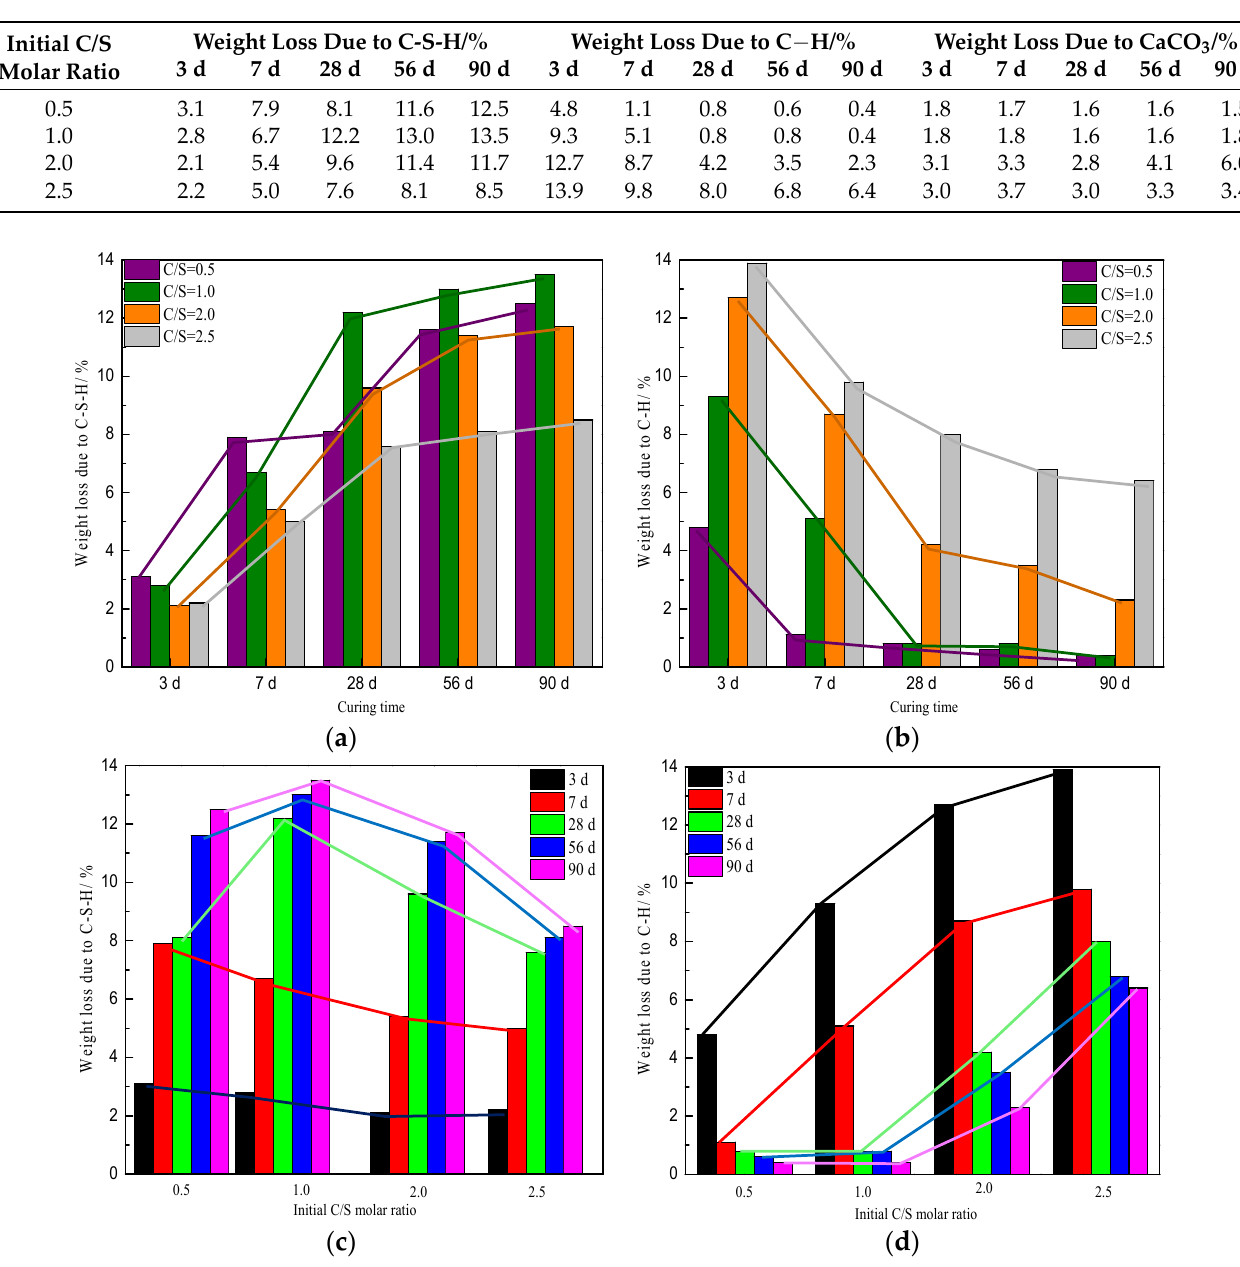
Table 2. Characteristic parameters of thermal weight loss.